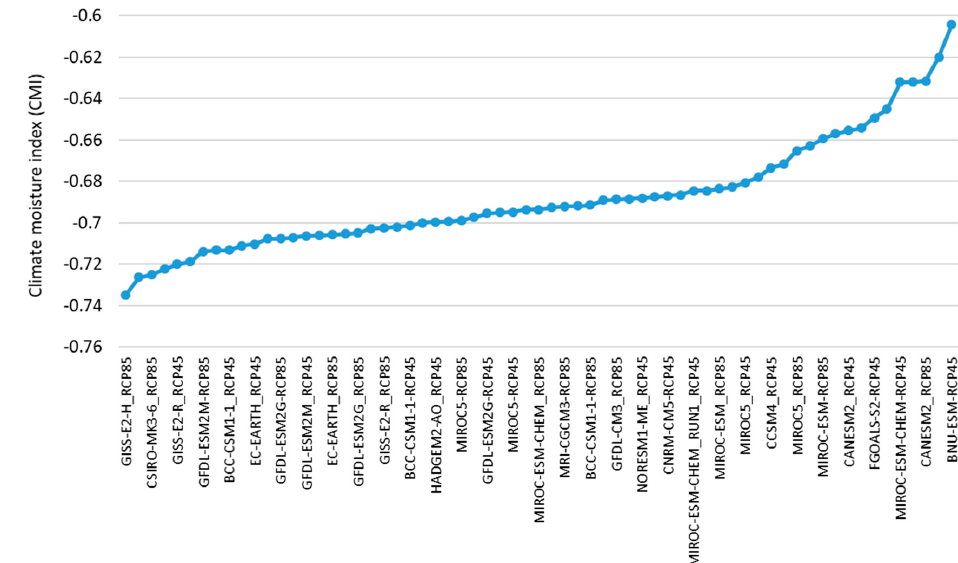
Figure 3. Climate moisture index (CMI) of different available representative concentration pathway-general circulation model (RCP-GCM) combinations. The lower the value of CMI, greater the aridity. The CMI is for the period (2010–2050).